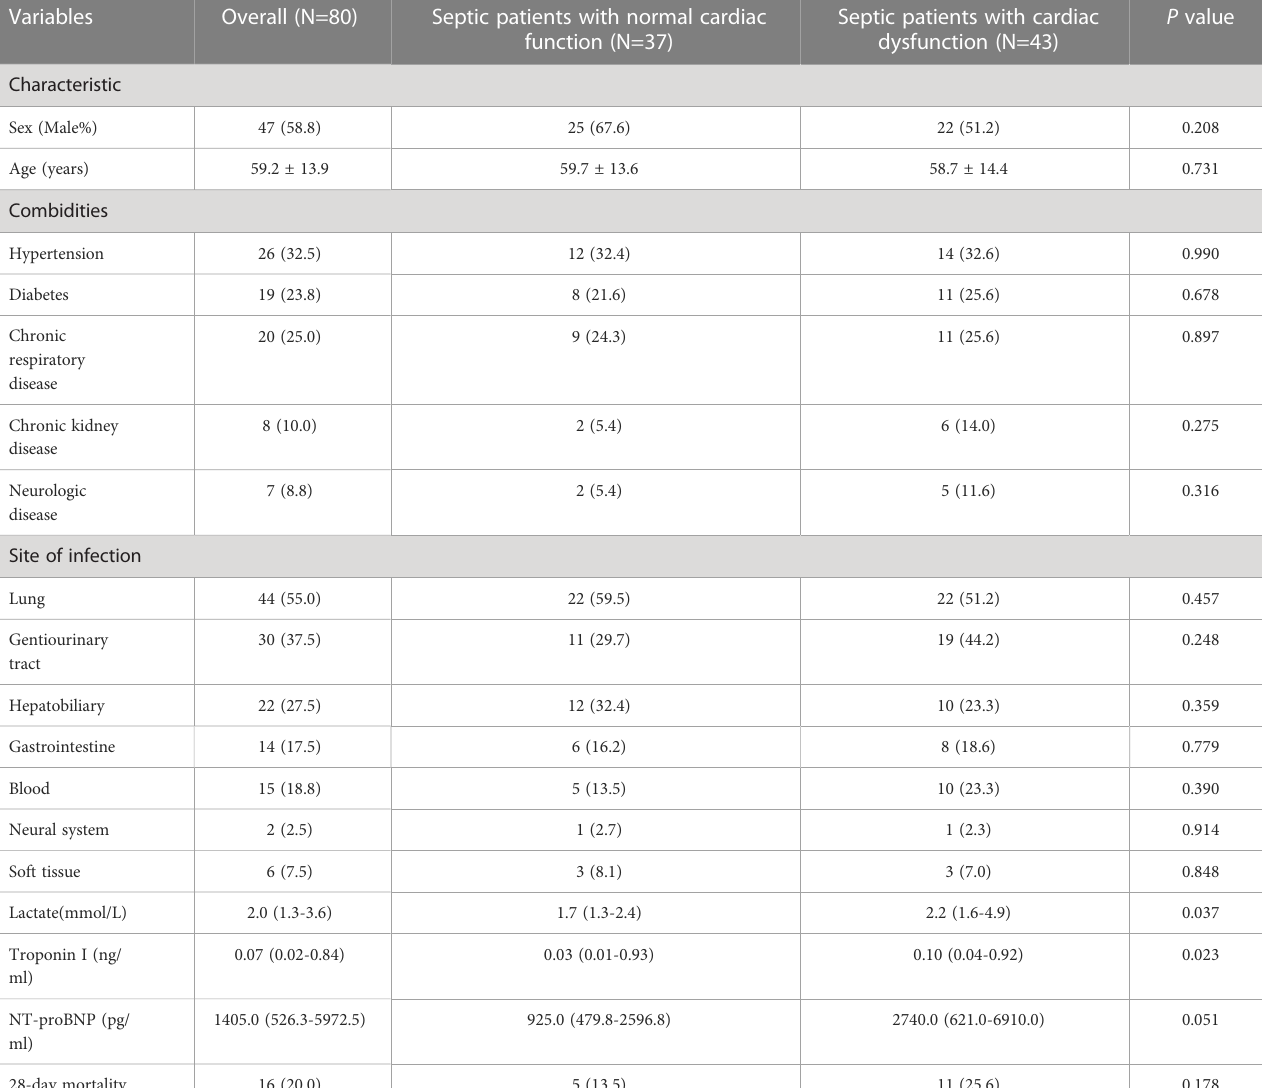
TABLE 1 Clinical characteristics of subjects enrolled in the